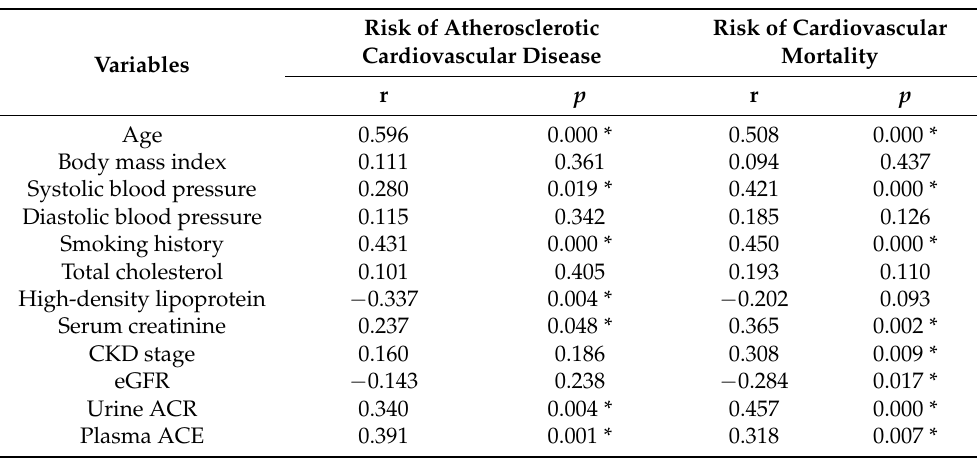
Table 3. Results of the correlational analysis between variables in this study.